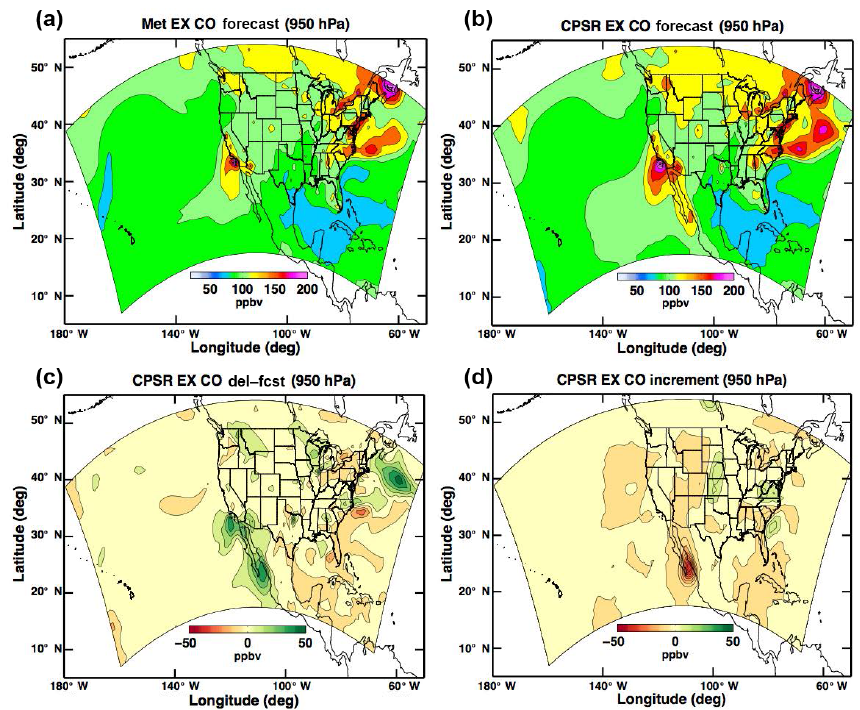
Figure 5. Shaded contours of CO in ppb for the MET and CPSR experiment 6h forecasts valid at this cycle time in panels (a) and (b) , respectively. Panels (c) and (d) represent the difference between the CPSR and MET forecasts (the CPSR experiment 6h forecast minus the MET experiment 6h forecast) in panels (a) and (c) and the assimilation increment for analysis at this cycle time in panels (b) and (d) . All figures are for ∼ 950hPa and the 9 June 2008, 18:00UTC, cycle. The curved rectangle represents the WRF-Chem